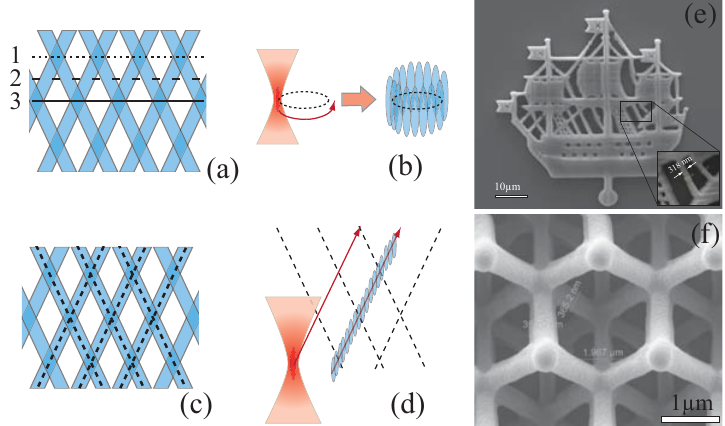
Figure 1. Two methods for fabrication 3D structures by the two-photon polymerization technology: raster scanning ( a , b ) and vector scanning ( c , d ); ( e ) scanning electron microscope image of the wind vane from the top of the Admiralty in Saint Petersburg, Russia, fabricated using the raster scanning approach; ( f ) scanning electron microscope image of the structure of inverted yablonovite fabricated using the vector scanning